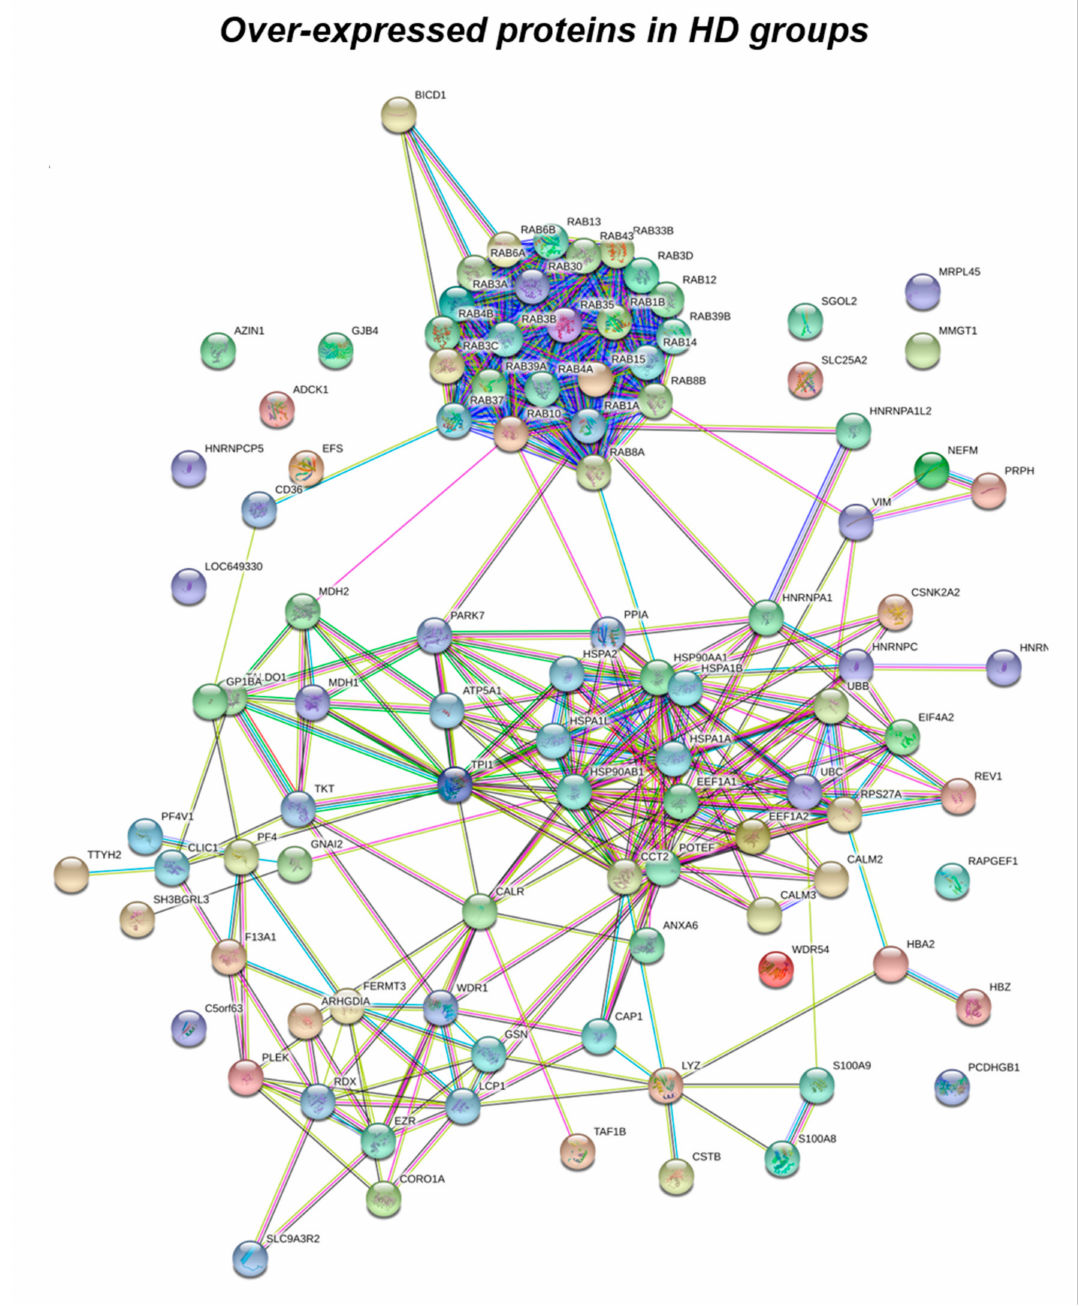
Figure 1. Functional network enrichment in the HD